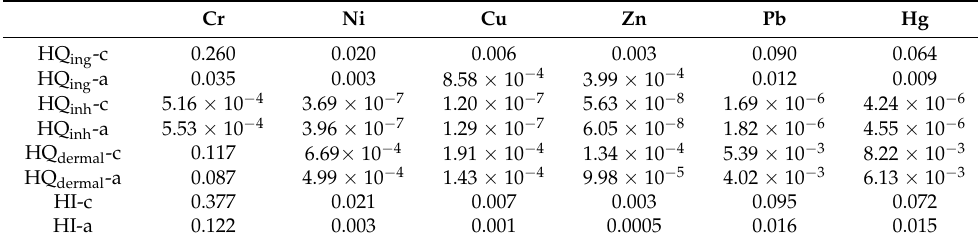
Table 8. The calculated HQ values for three exposure routes and HI values in this study. Cr Ni